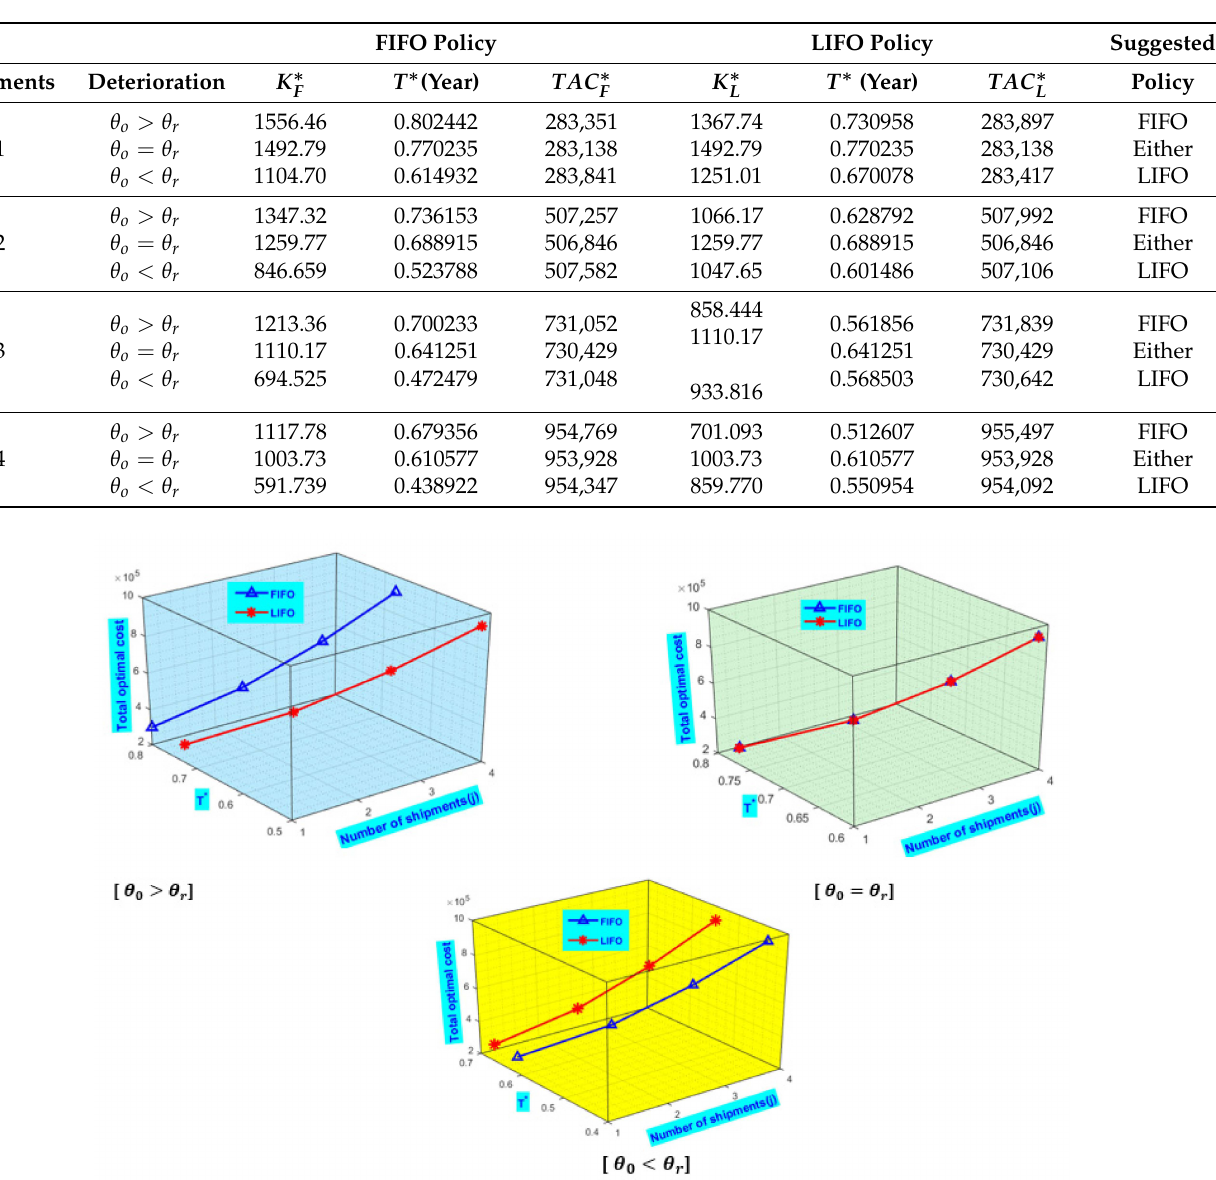
Table 7. Optimal cost of warehouse inventory system with frequency of shipments for various deterioration rates.